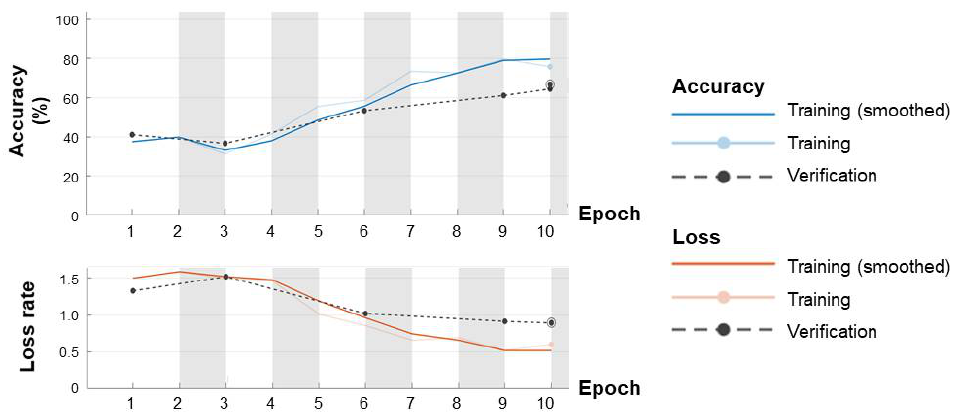
Figure 8. Representative accuracy and loss rate convergence curves of case 5 in the patient group.